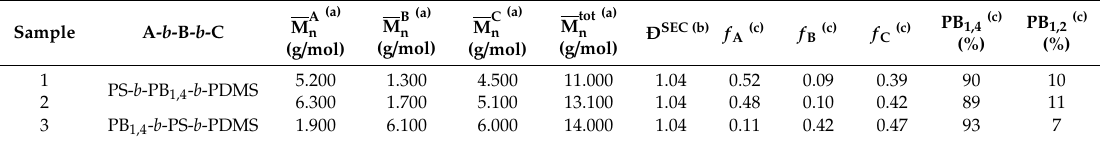
Table 2. Molecular characteristics of all blocks of the three triblock terpolymers